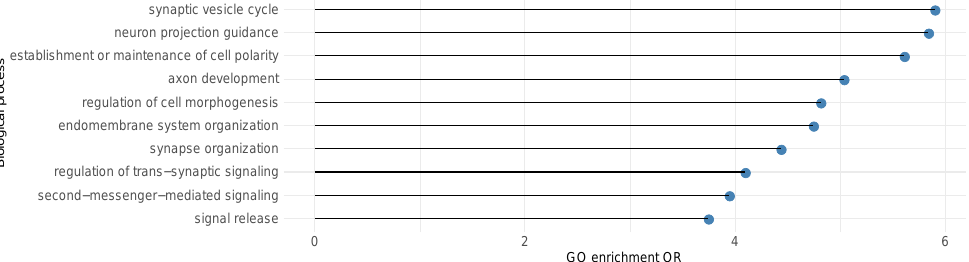
Figure 5. SCZ gene ontology(GO) enrichement analysis results for top biological processes with FDR ≤ 0.1. Enrichmed biological processes including synapse assembly (OR = 5.90) and neuron projection guidance (OR = 5.84) were discovered at FDR = 0.1, consistent with previous knowledge on